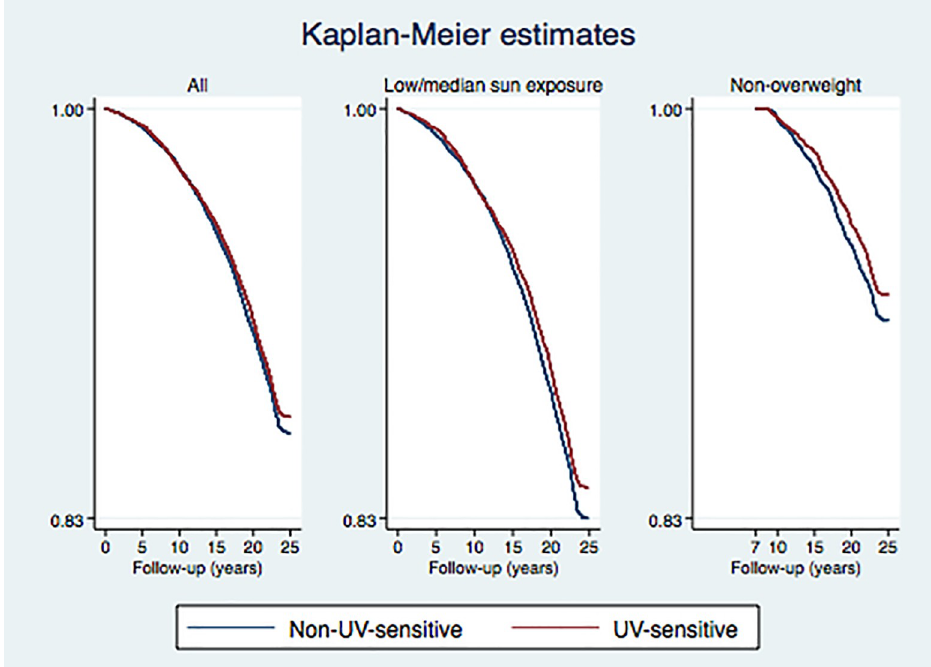
Fig 1. Kaplan-Meier (KM) graph of all-cause mortality in the total nested randomized observational study depending on UV–sensitivity, difference log-rank test p = 0.14. a. Fig 1B. KM graph showing main outcome among low and moderate sun exposure groups log-rank test p = 0.044. Fig 1C KM graph left truncated follow-up among non- overweight women from year 2000. Log-rank test p = 0.045.